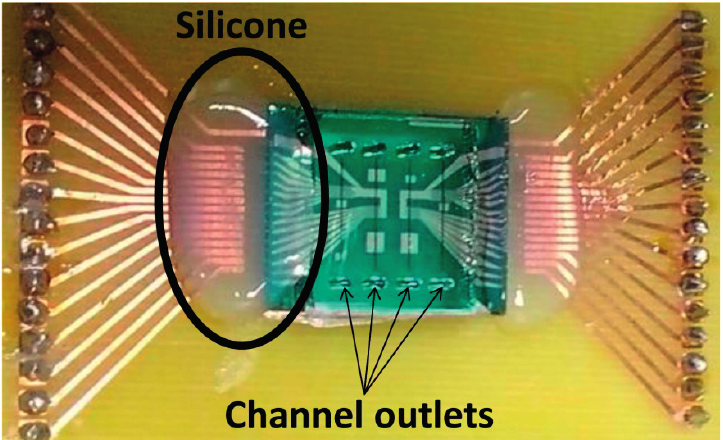
Figure 7. Wire-bonding silicon-protected assembled